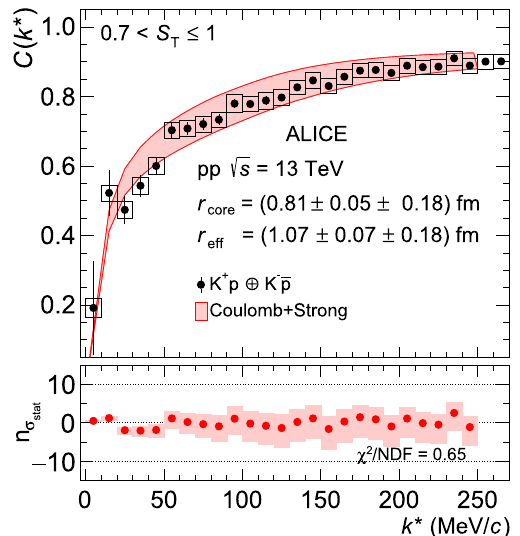
Fig. 1 K + p (K + p ⊕ K − p) correlation function obtained in pp col- √ s = 13 TeV. The measured data points are taken from lisions at Ref. [38] and are corrected for finite experimental momentum reso- lution and for residual correlations as described in Sect.4.1. Measured dataareshownbytheblackmarkers,theverticalerrorbarsandtheboxes represent the statistical and systematic uncertainties, respectively. The red band in the upper panel represents the model calculation and its systematic uncertainty as described in the text. The r core and r eff val- ues of the source are reported with their statistical and systematical uncertainties, respectively. Bottom panels represent the data-to-model